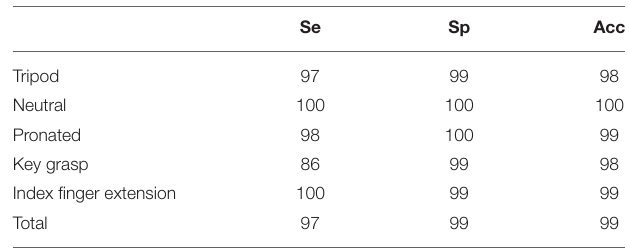
TABLE 6 | Performance metrics of experiment 3 [Se, sensitivity (%); Sp, specificity (%); Acc, accuracy